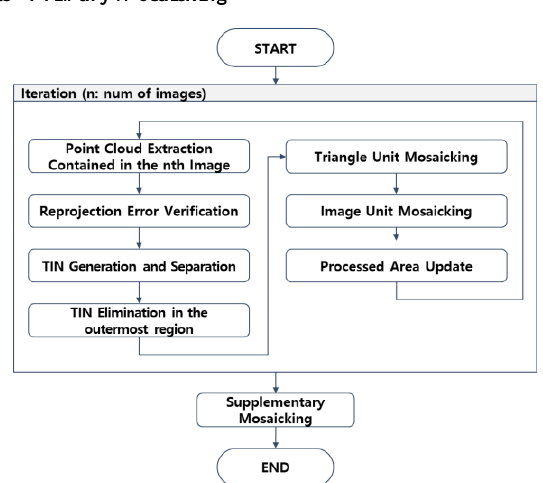
Figure 7 is an example of TIN generated in the proposed method.